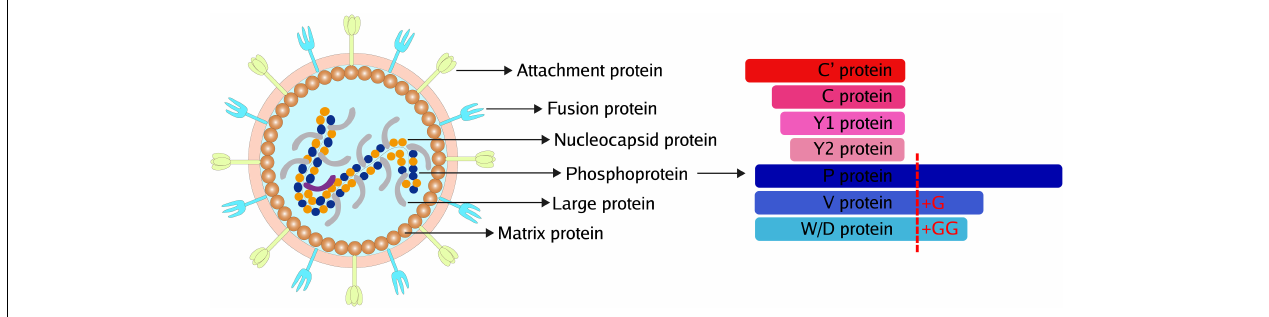
FIGURE 1 | Common Structure and accessory proteins of paramyxoviruses. The common structure of paramyxoviruses (Left) . The potential accessory proteins are encoded by paramyxoviruses (Right) .